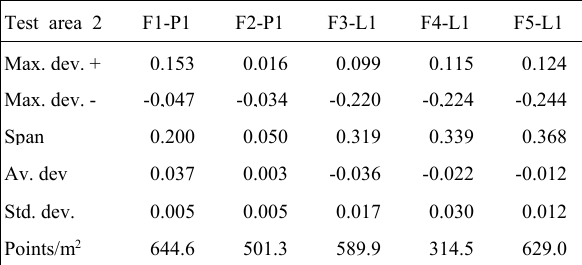
Table 4 . Deviations (  Z) of 3D point clouds of P1 and L1 at test area 1 for flight 1-5 (Unit [m]).